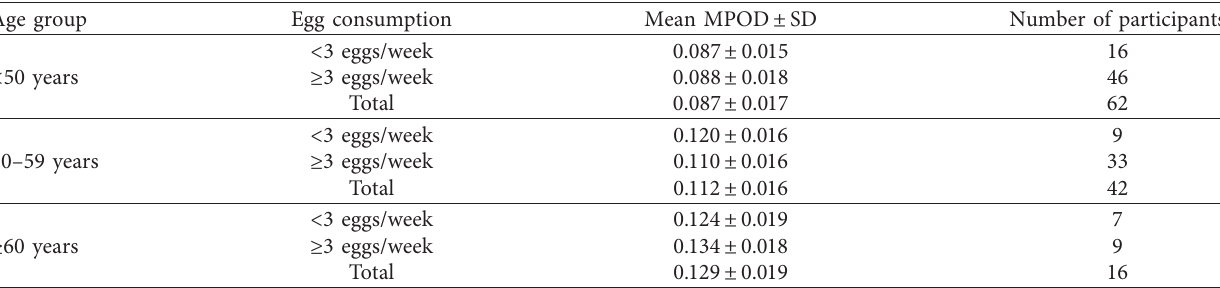
Values of mean MPOD in density units (d.u.); SD � standard